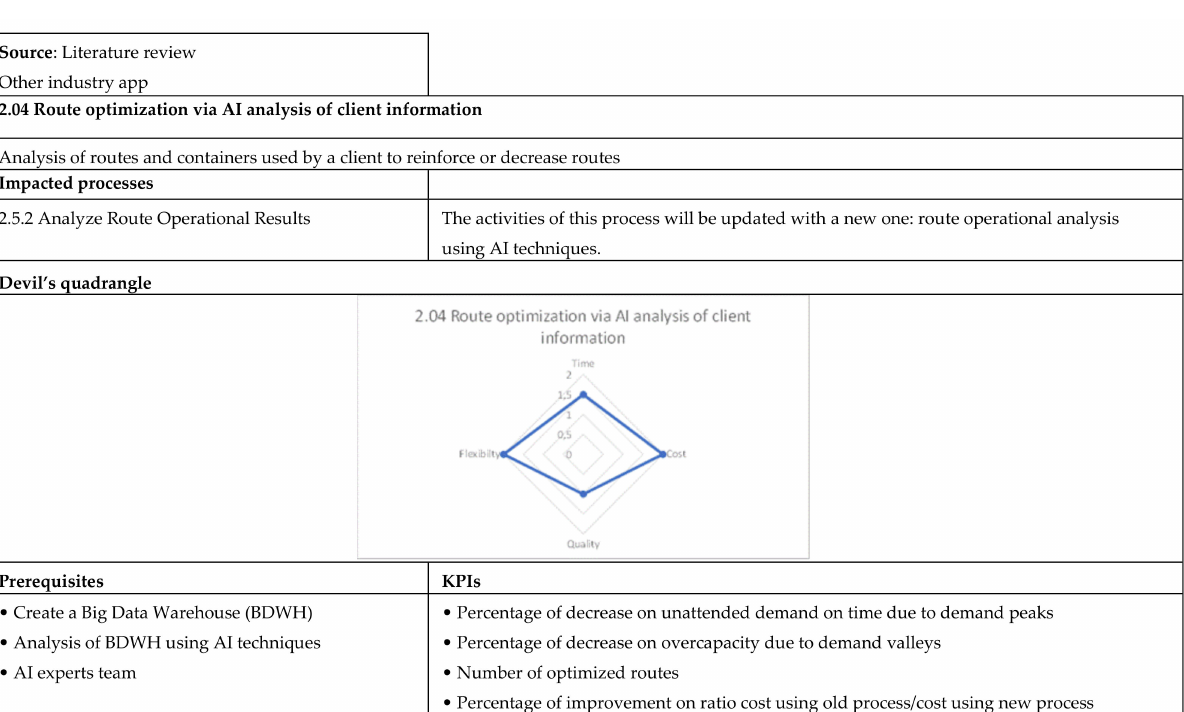
Figure A7. Pricing market prediction data sheet.